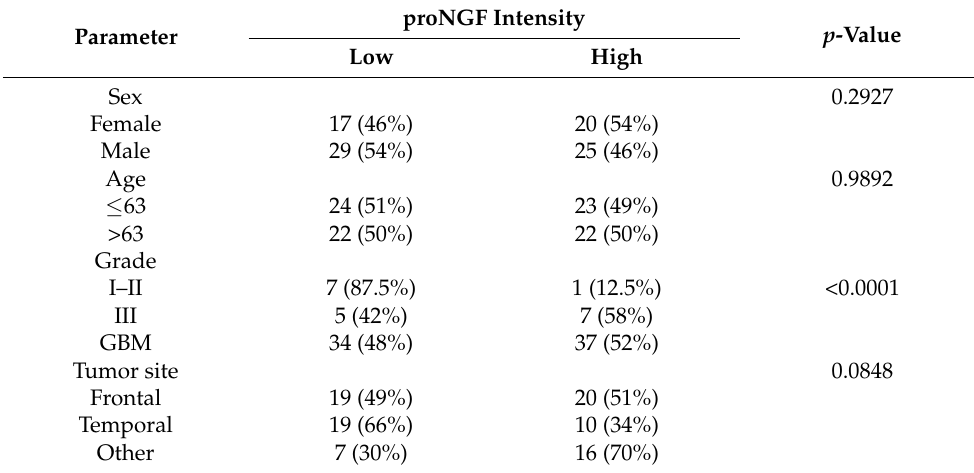
Table 1. Association between proNGF expression (staining intensity, h-score) and clinicopathological parameters in